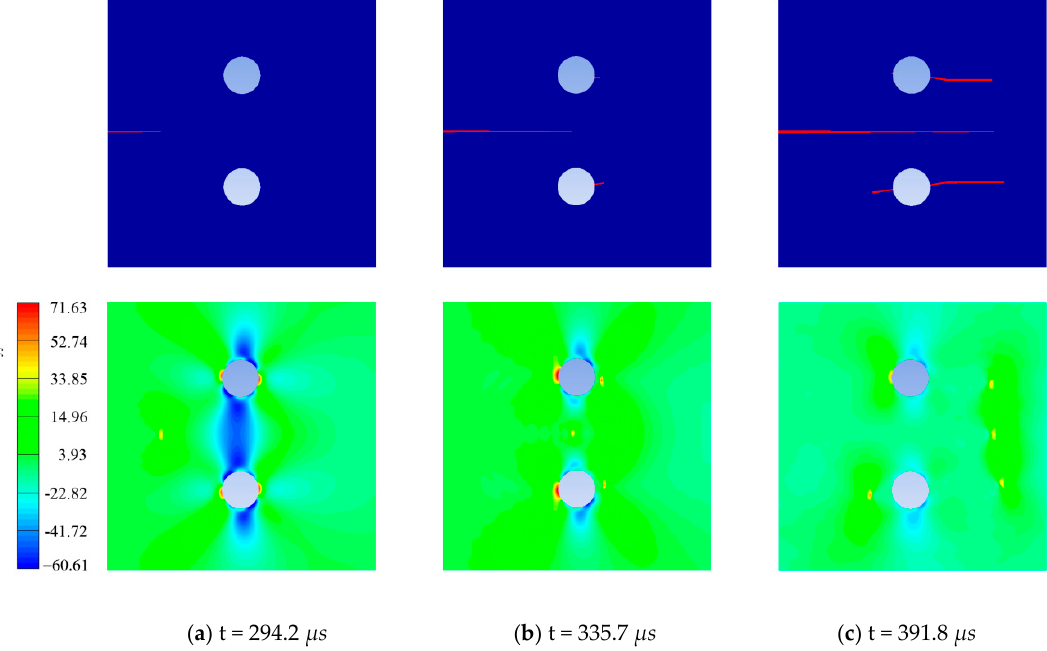
Figure 10. HT ‐ 1 specimen; ( a – c ) simulation results of the particle velocity vector contour plot calculated by AUTODYN; ( d – f ) principle diagram of the holes’ deformation.